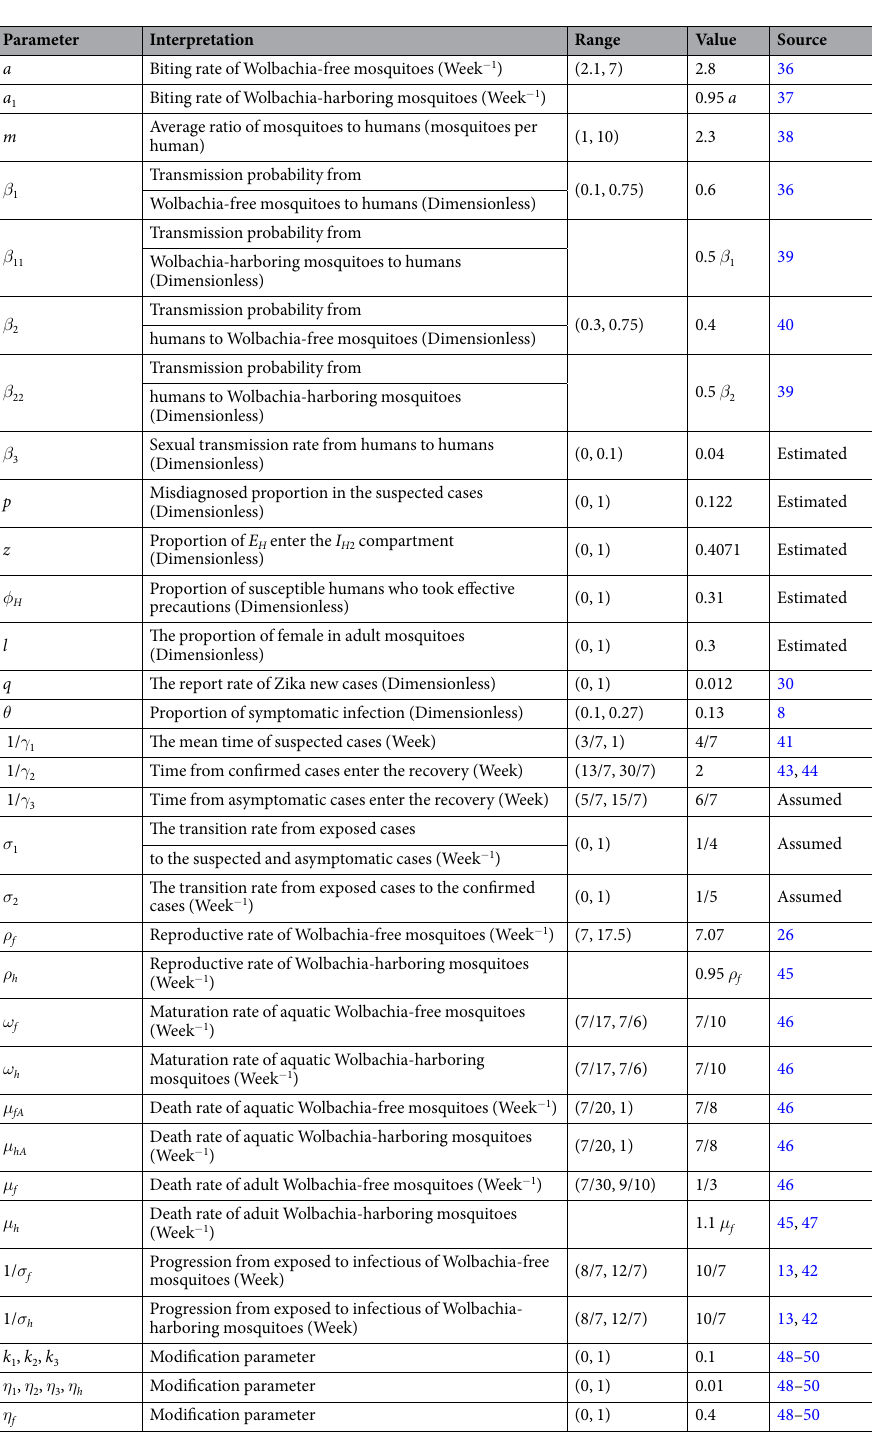
Table 1. Parameter descriptions, values and